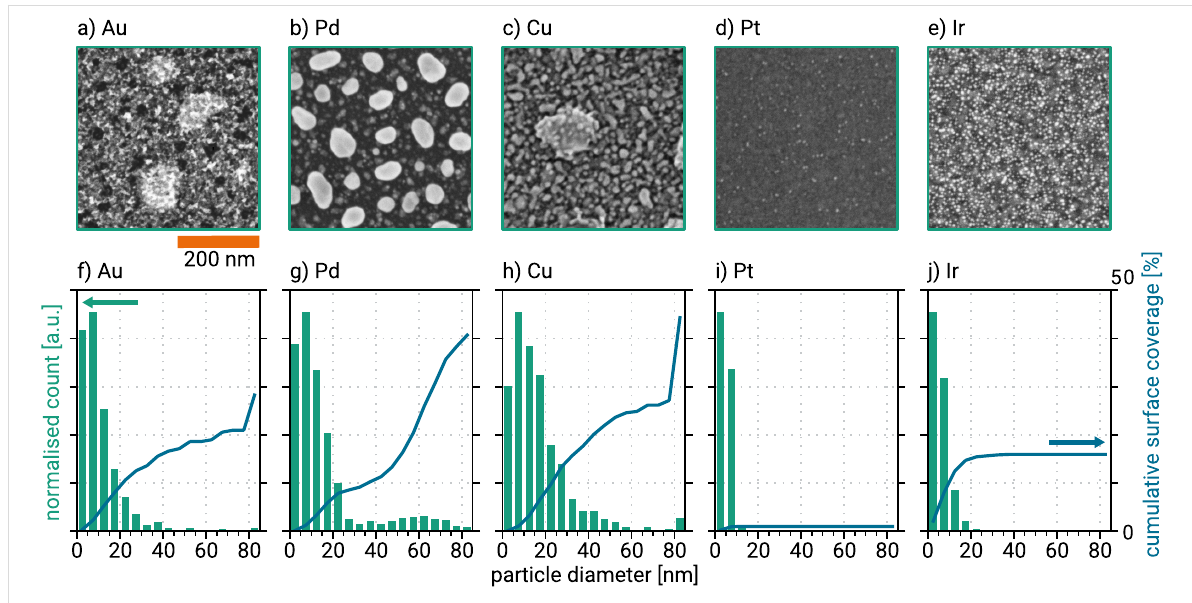
Figure 1: Fabricated noble metal particles. (a–e): SEM images of wafer surface; (f–j): particle size distribution (bars) and cumulative surface cover- age of the particles (solid